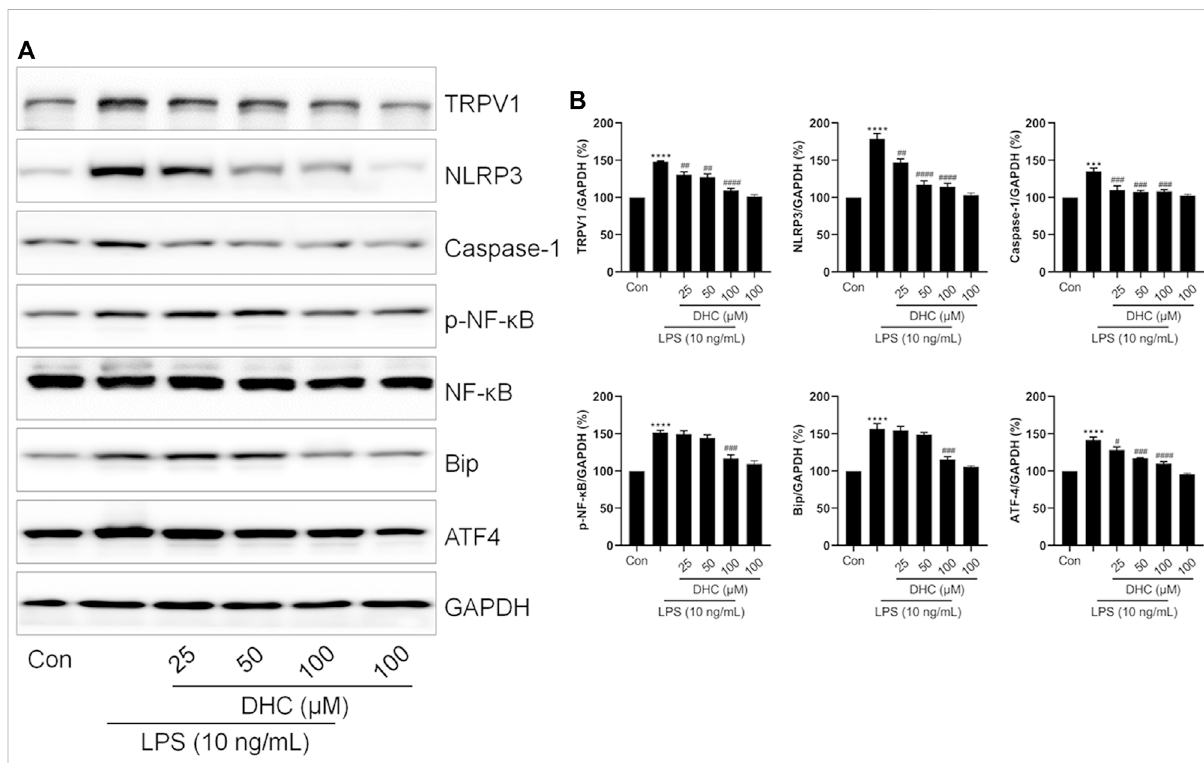
FIGURE 7 Validation oftheeffectsofDHC,chrysin,and7,8-DHFonin fl ammation-relatedproteins.RAW264.7cells wereexposedto LPSand treatedwith DHC,chrysin,or7,8-DHFfor 12 h. (A , B) The effectsofDHContheexpressions ofTRPV1,NLRP3,Caspase-1,p-NF- κ B,Bip,andATF4 wereexamined by Western blot ( n = 3). (C , D) The effects of chrysin on the expressions of ALOX12, p-I κ B α , I κ B α , p-NF- κ B, NLRP3, Caspase-1, Bip, and ATF4 were detected by Western blot. ( n = 3). (E , F) Western blot was employed to detect the effects of 7,8-DHF on the expressions of IKKB, p-I κ B α , I κ B α , p-NF- κ B, NLRP3and Caspase-1 ( n = 3). *p < 0.05 , **p < 0.01 , ***p < 0.001 , ****p < 0.0001 vs. Control groups ; #p < 0.05 , ##p < 0.01 , ###p < 0.001 , ####p < 0.0001 vs. LPS-treated